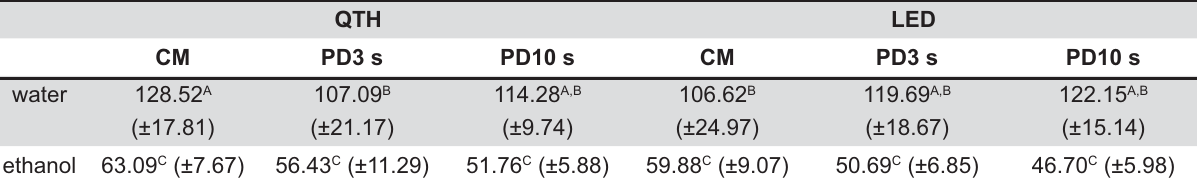
Values in the column with same superscript lower caser letter denote no statistical differences ( p>0.05) Table 3- (cid:2)(cid:3)(cid:4)(cid:5)(cid:6)(cid:7)(cid:8)(cid:2)(cid:7)(cid:9)(cid:5)(cid:6)(cid:10)(cid:5)(cid:11)(cid:10)(cid:2)(cid:10)(cid:4)(cid:12)(cid:13)(cid:5)(cid:9)(cid:13)(cid:14)(cid:6)(cid:7)(cid:2)(cid:15)(cid:16)(cid:17)(cid:18)(cid:19)(cid:2)(cid:20)(cid:14)(cid:11)(cid:2)(cid:21)(cid:13)(cid:5)(cid:22)(cid:13)(cid:5)(cid:23)(cid:2)(cid:24)(cid:4)(cid:22)(cid:25)(cid:11)(cid:5)(cid:23)(cid:2)(cid:7)(cid:9)(cid:11)(cid:4)(cid:6)(cid:26)(cid:9)(cid:27)(cid:2)(cid:5)(cid:9)(cid:2)(cid:28)(cid:29)(cid:2)(cid:30)(cid:31)!" 2